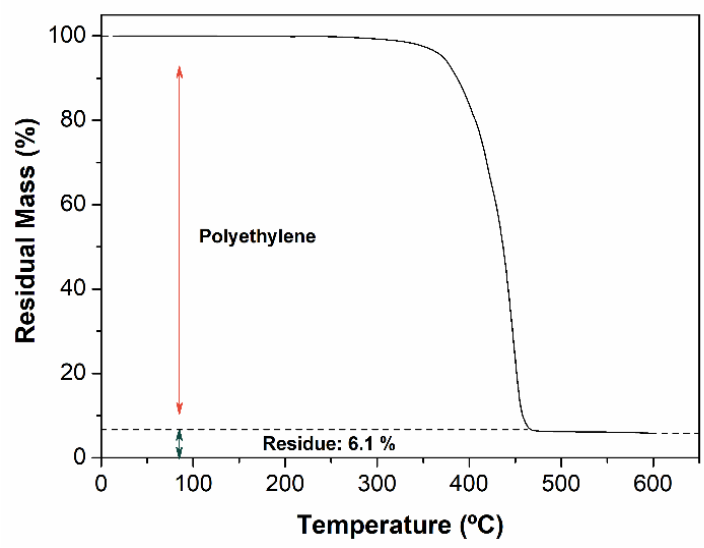
Figure 5 . TGA curve for the recycled fishing net. Figure 5. TGA curve for the recycled fishing